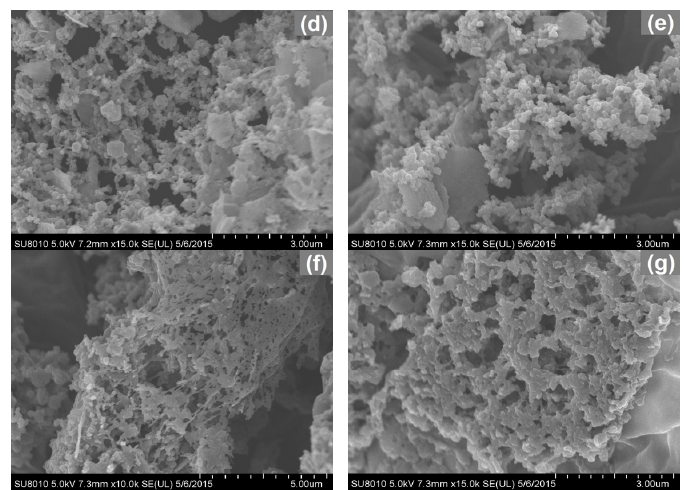
Figure 1. SEM images of eggplant hydrogels (EH) and carbon aerogels (CAs). ( a ) Ec; ( b ) EH 1 ; ( c ) EH 2 ; ( d ) CA 1 ; ( e ) CA 2 ; ( f ) CA 3 ; ( g ) CA 4 .